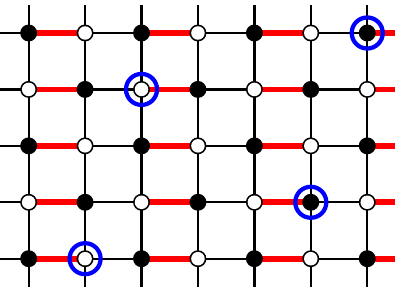
FIG. 2. The statically dimerized J 1 - J 2 Heisenberg model with thin black bonds and thick red bonds representing exchange couplings S · S of strength J 1 and J 2 , respectively, between S ¼ i j 1 = 2 spins. The A and B sublattices are indicated with solid and open black circles. The larger blue circles indicate randomly removed sites. For the intact system with j 2 ¼ J 2 =J 1 larger than ≈ 1 . 91 [58,82,83], the ground state is approximately a product j 2 c of singlets on the strong bonds, and upon dilution, the “ dangling spins ” remaining at the “ broken dimer ” adjacent to each removed spin constitute localized magnetic S ¼ 1 = 2